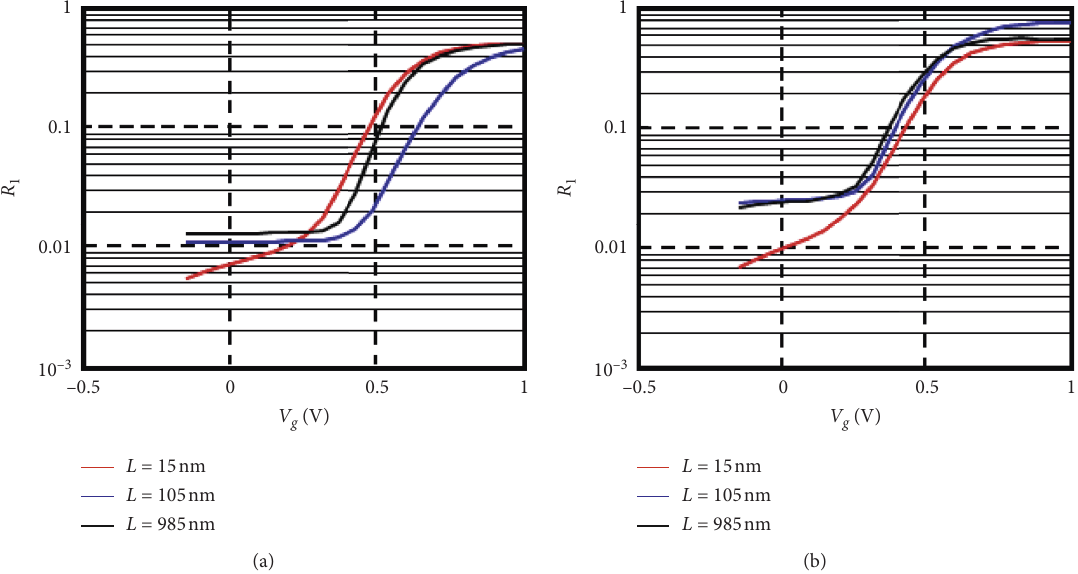
Figure 9: Ratio R 1 of contribution of the front interface noise level to the total noise level in the case of front channel conduction mode: (a) CNF+ Δ r model and (b) CNF +CMF+ Δ r